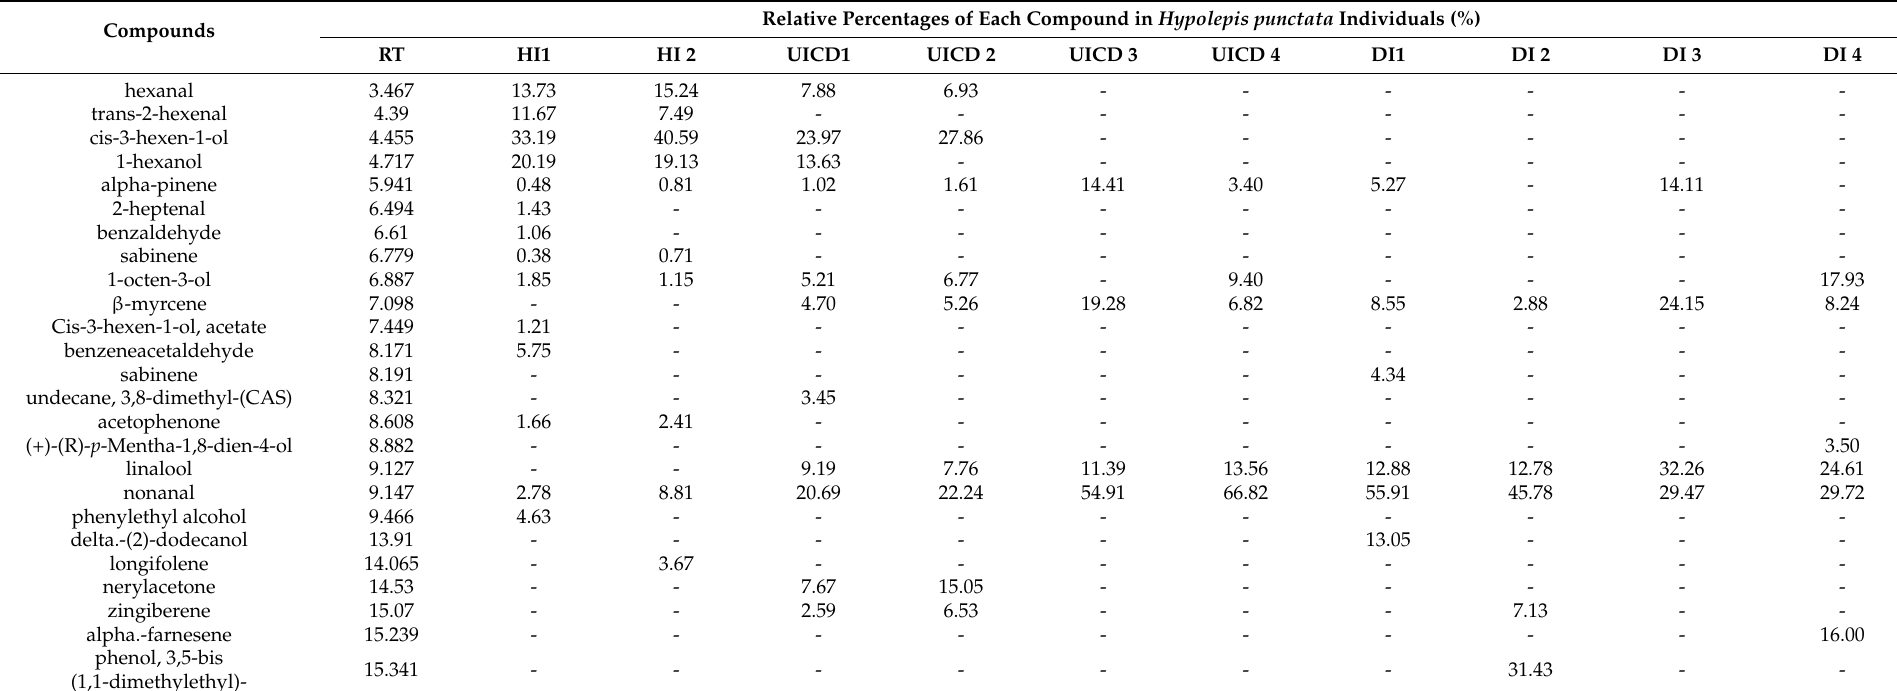
Table 3. Relative percentage of VOCs recorded from the individuals of healthy and Hypolepis punctata damaged by herbivory.